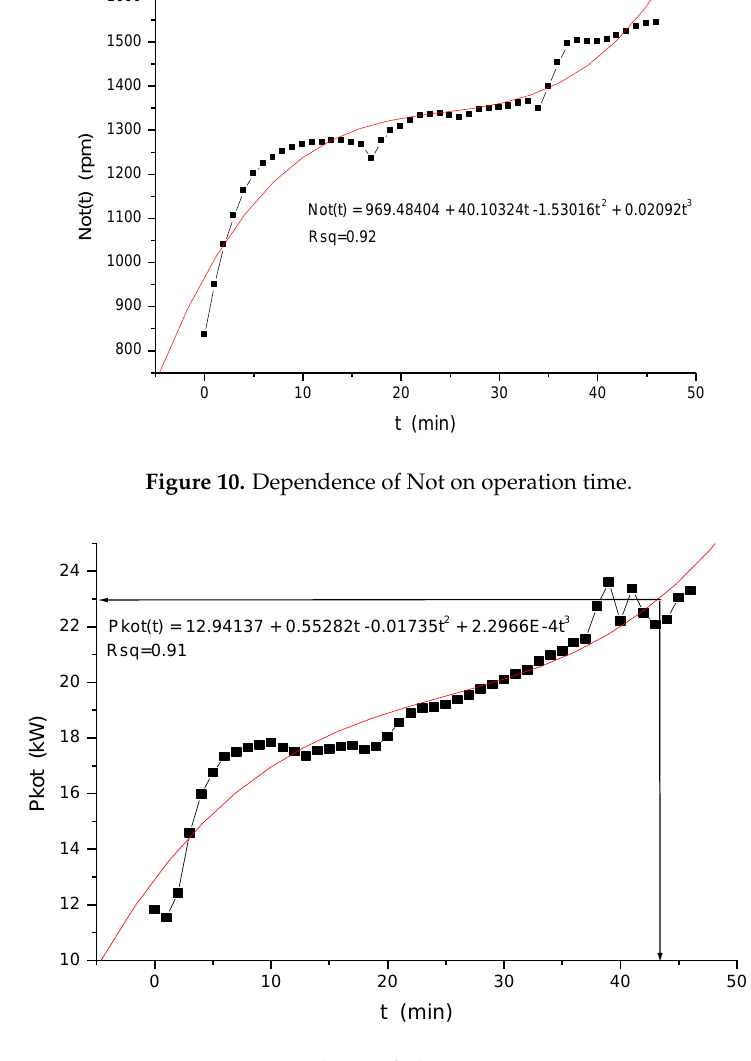
Figure 11. Dependence of Pkot on operation time.